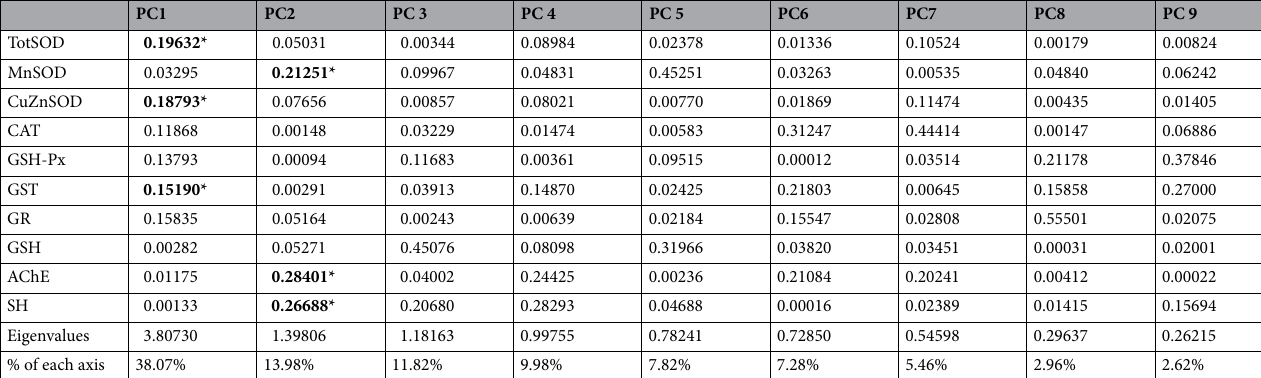
Table 2. Loadings of variables onto the principal components (PC). The parameters that contributed most to the separation are marked in bold and with an